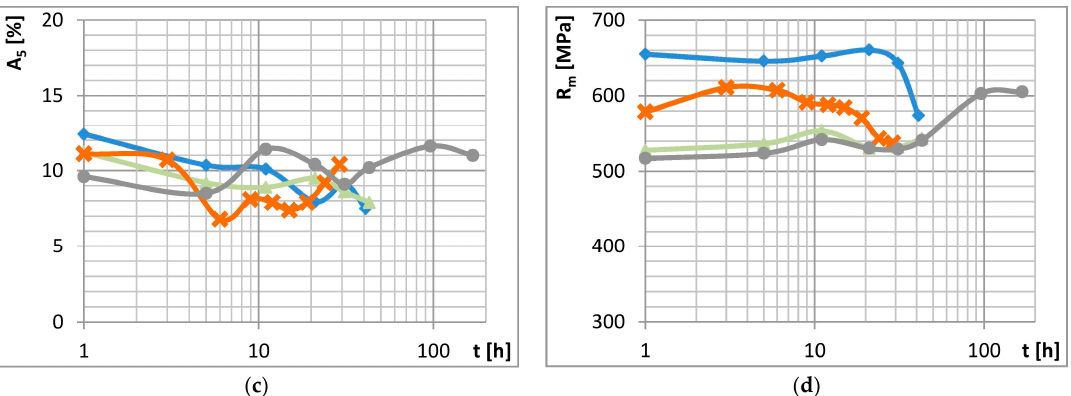
Figure 5. ( a ) Schematic representation of the AA conditions experiment and its results: ( b ) yield strength ( c ) elongation and ( d ) ultimate strength vs. time of AA.